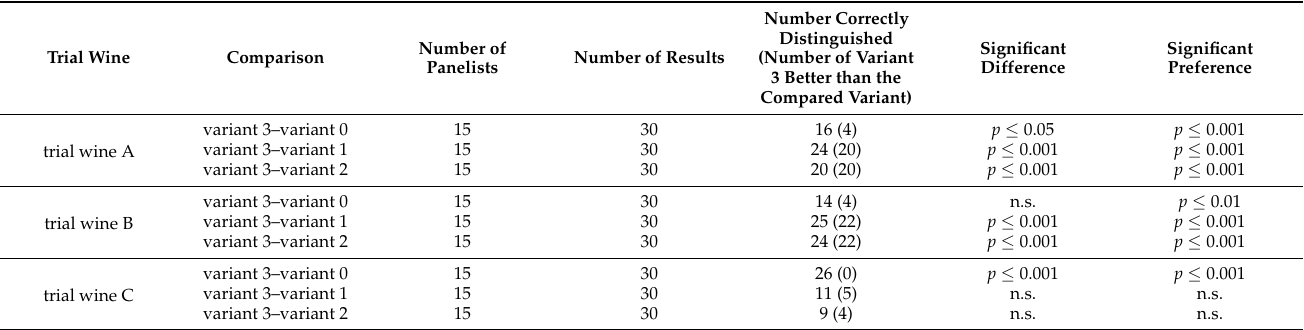
Table 2. Evaluation of the triangle tests in the small-scale experiment according to the significance table at the significance level p > 0.05 (not significant, n.s.), p ≤ 0.05 (significant), p ≤ 0.01 (highly significant), and p ≤ 0.001 (very highly significant) of [37].